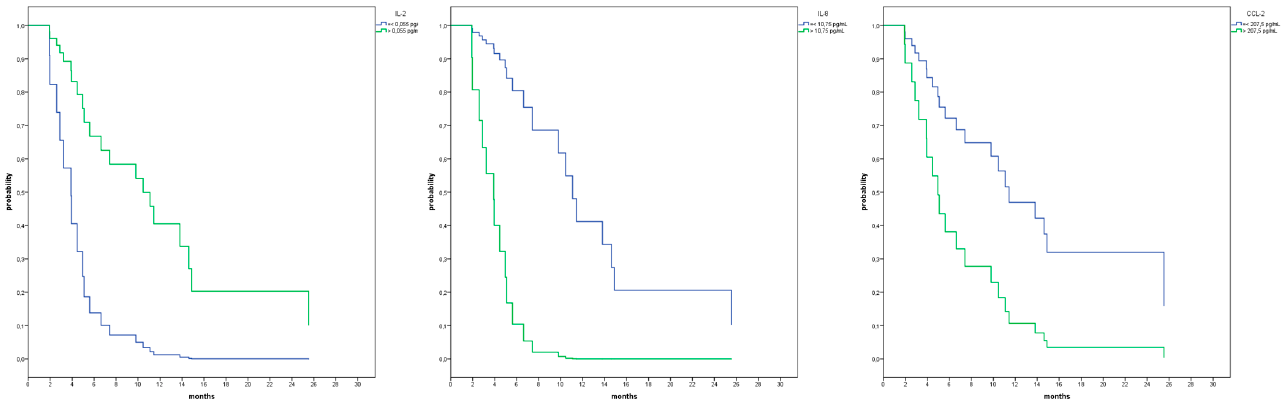
Figure 1. Cox analysis performed for IL-2 and 8 pts with an interleukin (IL)-2 concentration of ≤ 0.055 pg/mL and a 15 pts concentration of >0.055 pg/mL (hazard ratio (HR), 0.204; 95% CI, 0.075–0.559; p = 0.002). Cox analysis performed for IL-8 and 14 pts with an IL-8 concentration of ≤ 10.75 pg/mL and a 9 pts concentration of >10.75 pg/mL (HR, 0.096; 95%CI, 0.024– 0.383; p = 0.001). Cox analysis performed for CCL-2 and 8pts with a CCL-2 concentration of ≤ 207.5 pg/mL and a 15 pts concentration of >207.5 pg/mL (HR, 0.338; 95% CI, 0.127–0.903; p = 0.031).